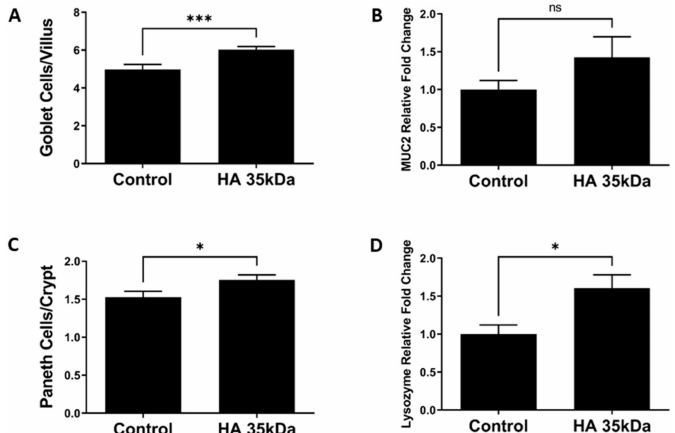
Figure 3. Effects of oral HA 35 KDa supplementation on goblet cell number per villus ( A ; n = 168 villi; p = 0.0009), MUC2 mRNA expression ( B ; n = 20; p = 0.5027), Paneth cell number per crypt ( C ; n = 162 crypts; p = 0.0247), and lysozyme mRNA expression ( D ; n = 22; p = 0.0127) in ileal tissue from both groups. Data presented as mean ± SEM. HA: hyaluronic acid; MUC2: mucin 2; SEM: standard error of the mean. * p < 0.05, *** p < 0.001, ns = not